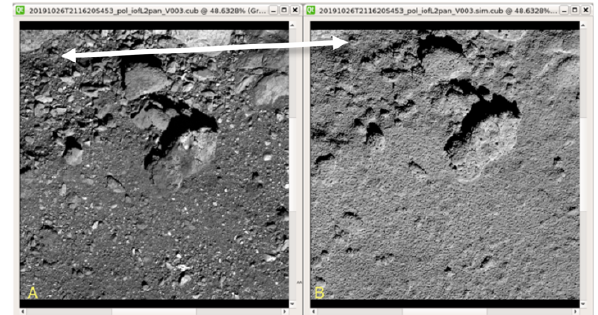
Figure 8. Left (A): input PolyCam I/F image. Right (B): image simulated with a priori exterior orientation, OLA DTM, and photometric model (from Becker et al., 2020). The double- headed arrow indicates a corresponding feature in both